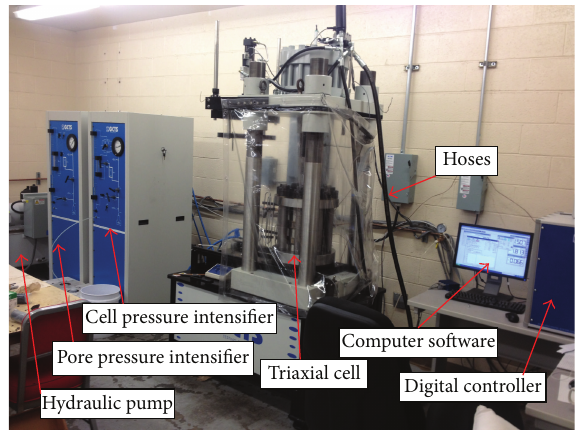
Figure 2: The GCTS triaxial rock test system.